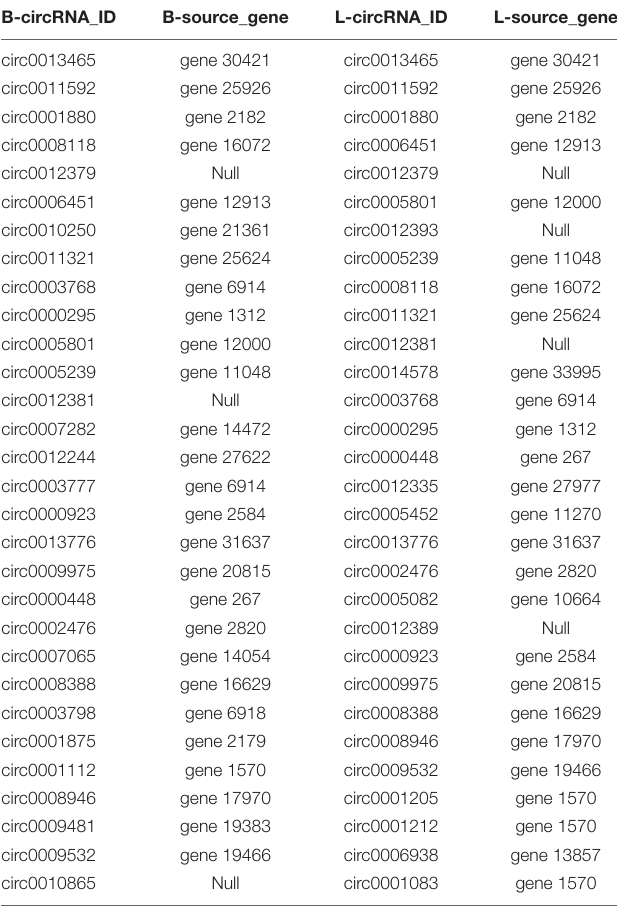
TABLE 3 | The 30 circRNAs with the highest expression in each